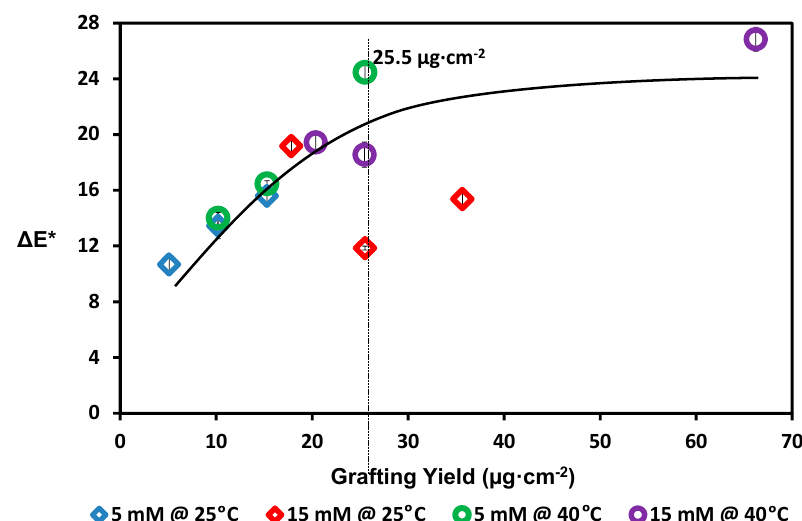
Figure 3. Change of the membrane color ( ∆ E*) with grafting yield; common reaction condition is pH 5.5 (0.1 M sodium acetate buffer), and 0.5 U·mL − 1 enzyme (laccase). Reaction at 25 °C using 5 mM 2-AP (blue diamond) and 15 mM 2-AP (red diamond), and reaction at 40 °C using 5 mM 2-AP (green circle) and 15 mM 2-AP (purple circle). Resection times 30, 60, and 120 min were tested and the grafting yield was increased with increasing the reaction time. The solid black line is a guide for general trend.